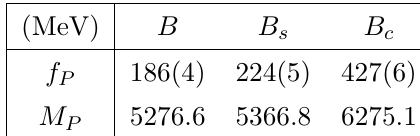
Table 7 . Decay constants and masses for B mesons ( f B is an average for B 0 and B (cid:6) ), B s , B c [86].